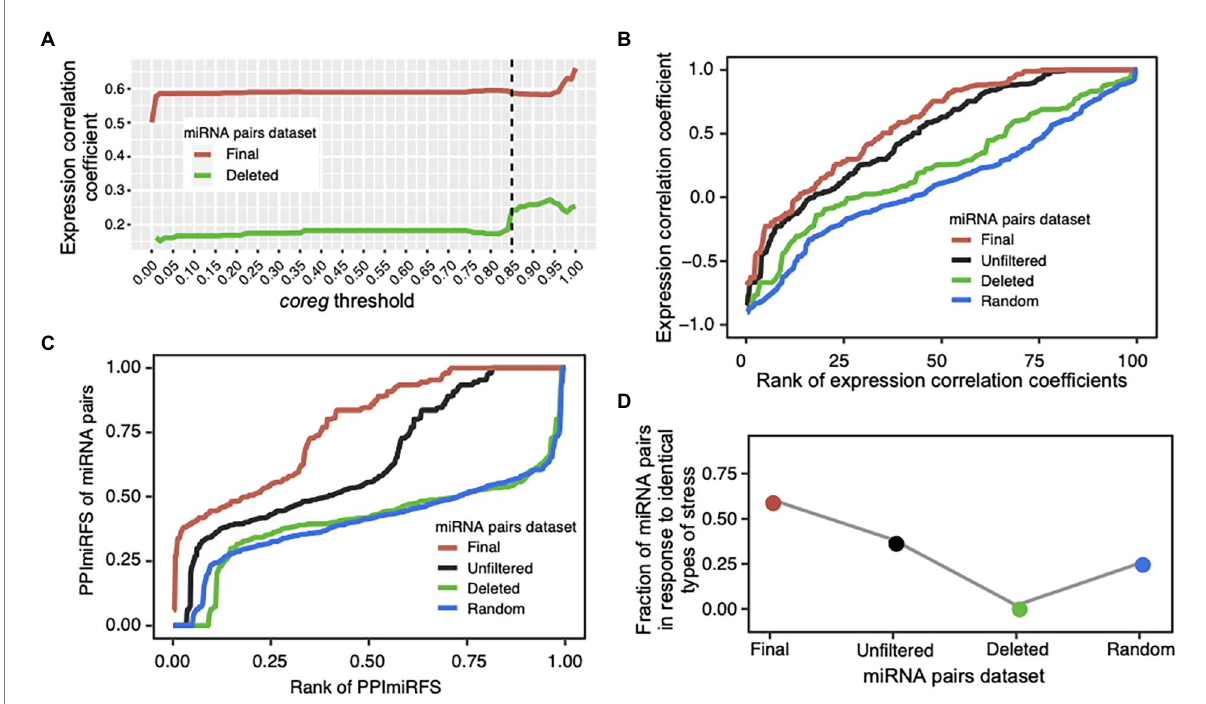
FIGURE 3 Validation of cooperative miRNA–miRNA pairs. (A) Average Pearson’s expression correlation coefficients of the miRNA pairs in the “final” (red line) and “deleted” (green line) datasets under a certain coreg threshold (0 ≤ coreg ≤ 1). The coreg threshold of 0.85 (dotted line) was used to filter the initial “unfiltered” miRNA pairs that share at least one target transcript. Under this threshold, the correlation coefficient of the miRNA pairs sharply increased in the “deleted” dataset. (B) Quality evaluation of the miRNA–miRNA crosstalk network using expression profiles. Correlation coefficient values were ranked increasingly for all miRNA pairs in the four datasets: “unfiltered”—the initial miRNA pairs dataset that share at least one target transcript (black line), “final”—the miRNA–miRNA crosstalk dataset after filtering the initial dataset using the coreg threshold of 0.85 (red line), “deleted”—the miRNA pairs that have no common target under the coreg threshold of 0.85 (green line), and “random”—the randomized miRNA pairs with the same topology as the “final” network, and generated by shuffling the node labels while keeping the edges constant (blue line). The “final” dataset shows the significantly highest expression correlation coefficient. (C) Evaluation of miRNA pairs using PPImiRFS. PPImiRFS scores were ranked increasingly in each dataset. PPImiRFS was used to infer the functional similarity scores of miRNA pairs based on a protein–protein interaction network with semantic similarity weights generated using GO terms and graph theoretical properties (Meng et al., 2015). The “final” dataset corresponds to the highest PPImiRFS scores. (D) Fraction of the miRNA pairs in response to the identical type of stress. The “final” dataset obtained the highest fraction of miRNA pairs responsive to the identical type of stress, and the “deleted” pairs showed the lowest